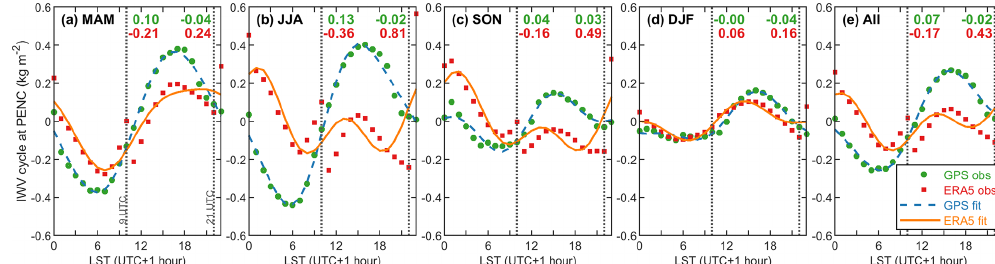
Figure 9. Similar to Fig. 8 but for the seasonal-averaged and all-time-averaged diurnal IWV cycles at station PENC. The green and red numbers are the IWV shifts from ERA5 and GPS, respectively. The numbers on the left and right are the IWV shifts from 09:00 to 10:00UTC and from 21:00 to 22:00UTC,